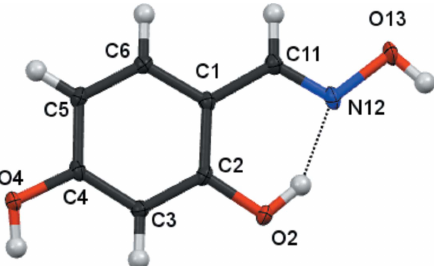
Figure 2 The molecular structure of compound 2 , showing 80% displacement ellipsoids.